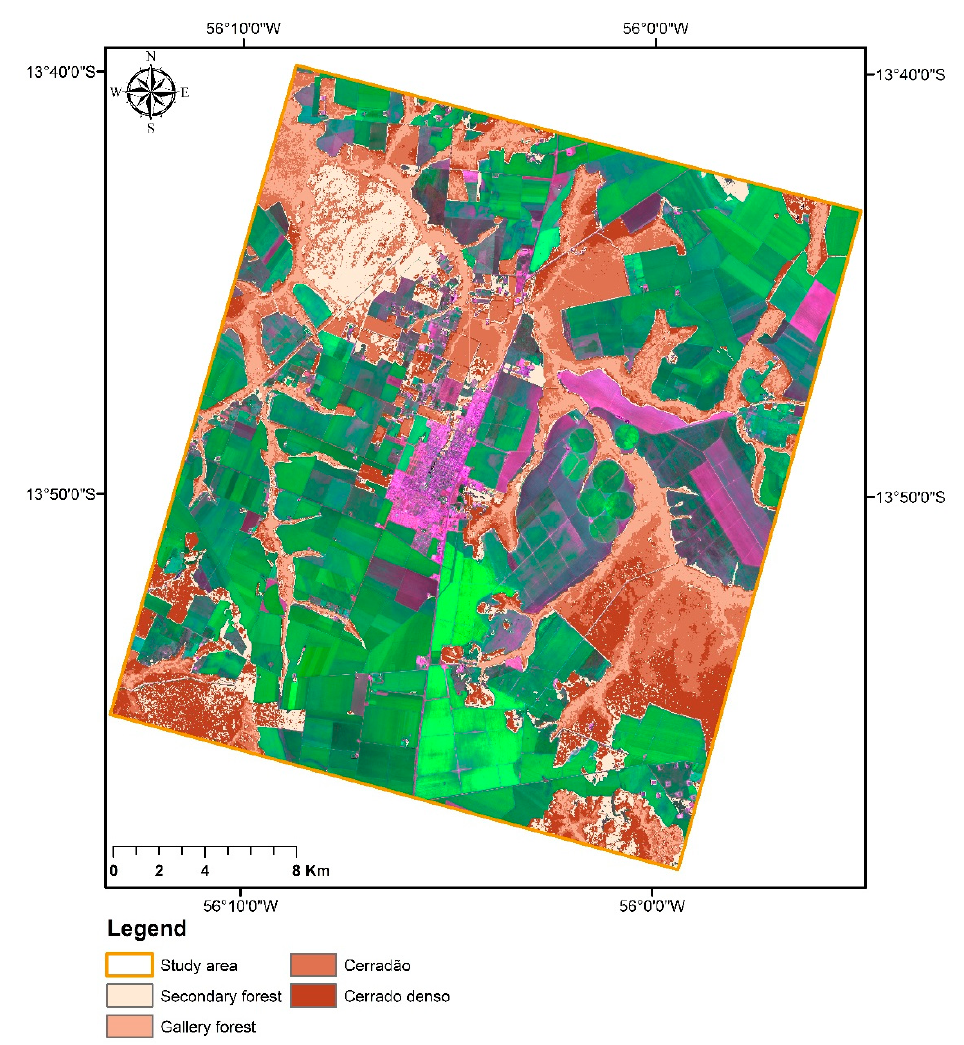
Figure 9. Classification of Cerrado forest type using all images from the dry and rainy season on top of a false color composition from Sentinel 2A, Bands 3, 4, and 8 (07 July 2017).